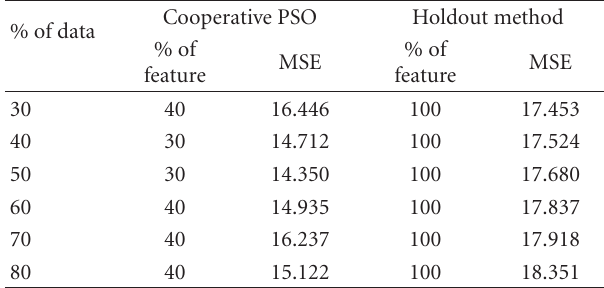
Table 16: The comparison of RMSE obtained when using CPSO and standard fuzzy model with holdout method for computer data with C =